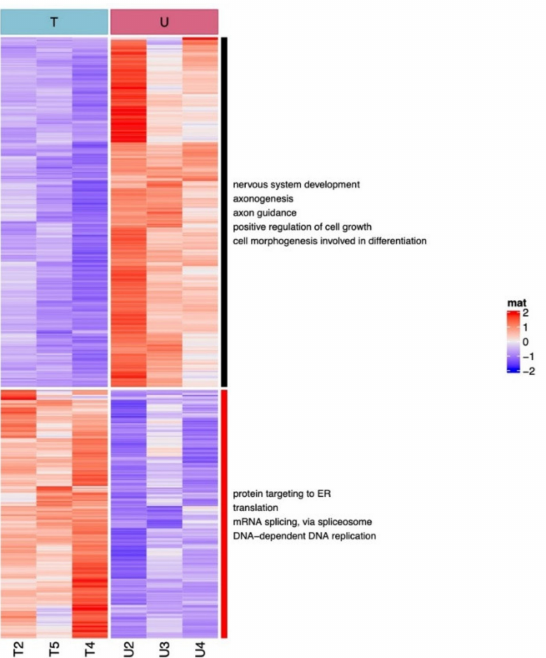
Figure 4. Genes differentially regulated by TUDCA vs. UDCA and main biological pathway . Starting with genes deregulated in TUDCA vs. UDCA, a heatmap was constructed with diverg- ing color scale (red for up-regulated genes and blue for down-regulated genes). Genes (in line) were ordered using Euclidean distance. Two major gene clusters appeared. They were annotated with